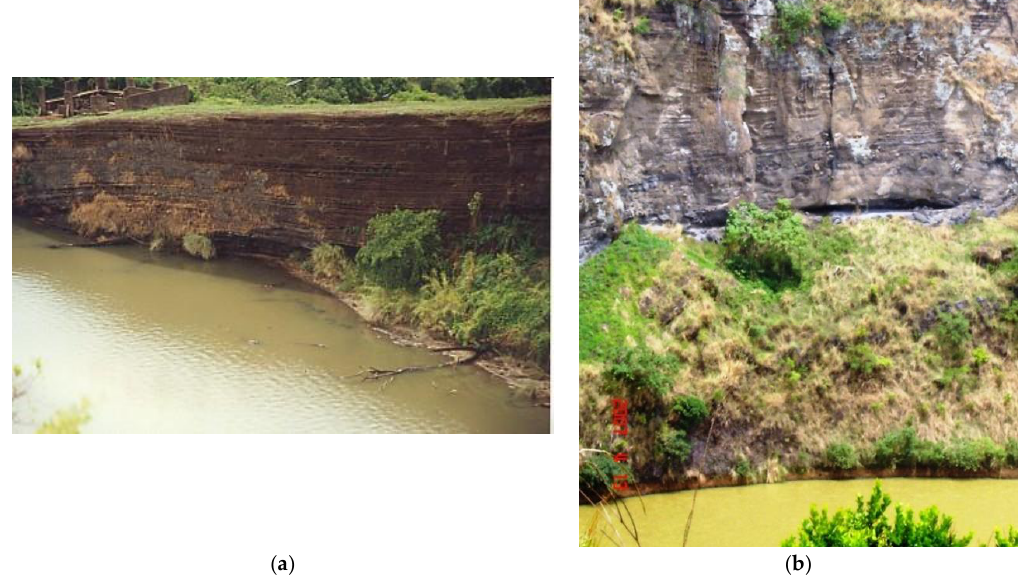
Figure 6. ( a , b ) Tephra layers of the Lake Nyos pyroclastic deposits near the outlet. Thinly stratified surge deposits of Nyos maar with cross-bedding. The slightly reddish color in ( b ) reflects an important weathering of the deposits by water (June 2001 and August 2006).